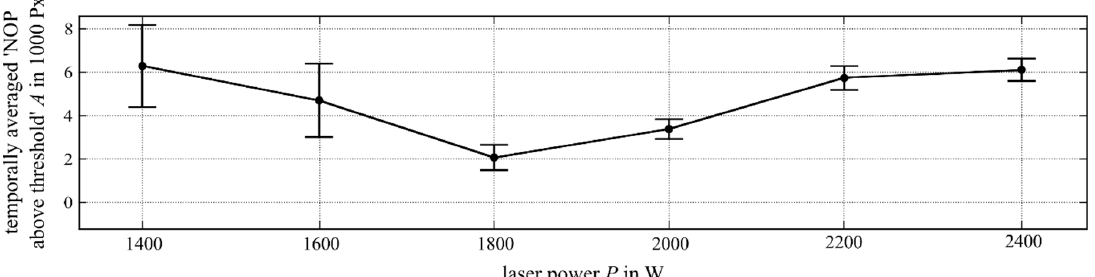
Figure 6. Temporally averaged NOP (over an intensity threshold of 948 digits) over the laser power variation. The temporal standard deviation is shown for each experiment.